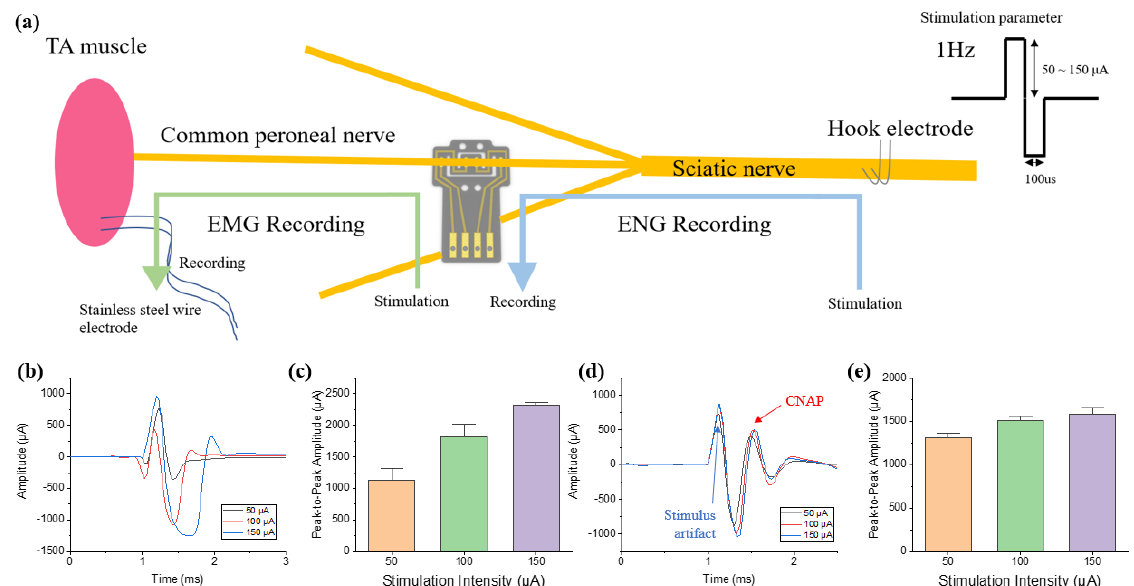
Figure 6. In vivo experiments of neural signal recording and neural stimulation: ( a ) Schematic of stimulation and recording process; ( b ) The recorded EMG signals according to the nerve stimulation through DCNI; ( c ) Peak-to-peak amplitude of the EMG signals (n = 60); ( d ) The recorded ENG signals through DCNI according to the nerve stimulation through a hook electrode; and ( e ) Peak-to-peak amplitude of the CNAP (n = 60).